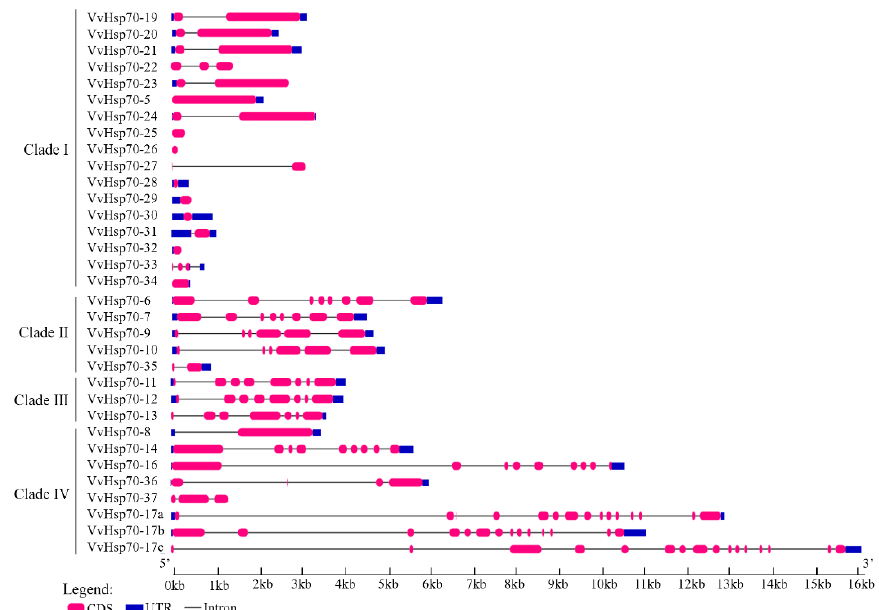
Figure 2. Gene structure of VvHsp70 genes. The red blocks represent the coding sequence (CDS), the blue blocks represent untranslated region (UTR), and the black lines represent introns. The exons and introns can be estimated using the scale at the bottom. Clades I–IV stand for the subfamilies I to IV.